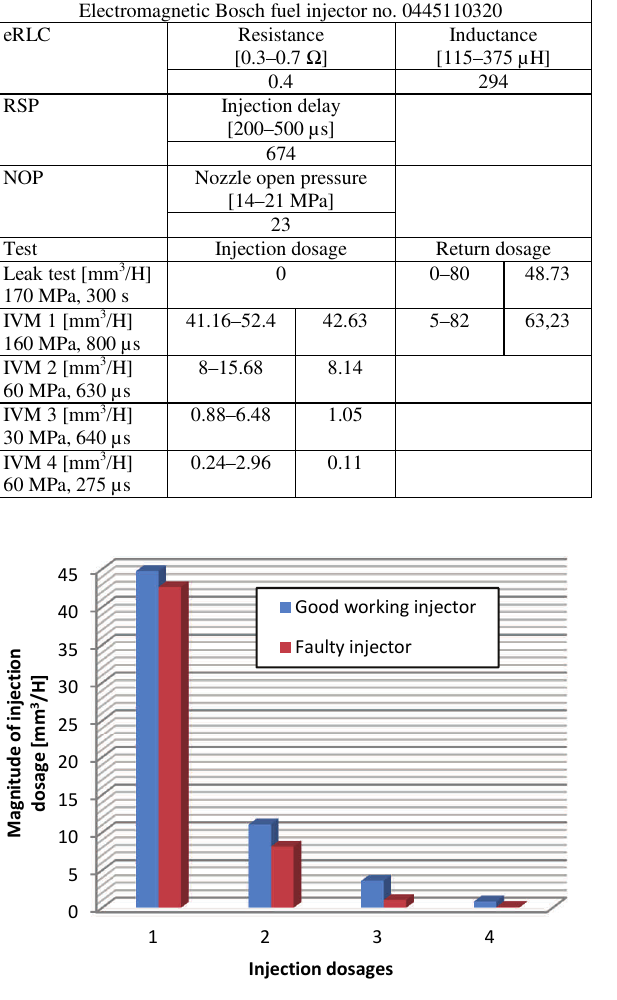
Fig. 12. Injection dosages comparison between faultless and faulty elec- Fig. 13. Injection dosages comparison between faultless and faulty piezoe- tromagnetic Bosch fuel injector; 1 – full load dosage, 2 – medium load lectric Bosch fuel injector 1 – full load dosage, 2 – initial dosage, 3 – dosage, 3 – idle speed dosage, 4 – initial dosage